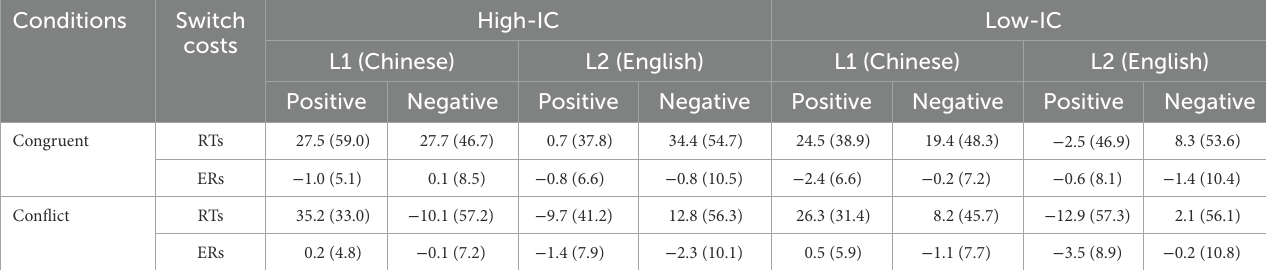
TABLE 5 Descriptive statistics of high- and low-IC ability groups’ language switch costs in different emotional conditions. Conditions Switch costs